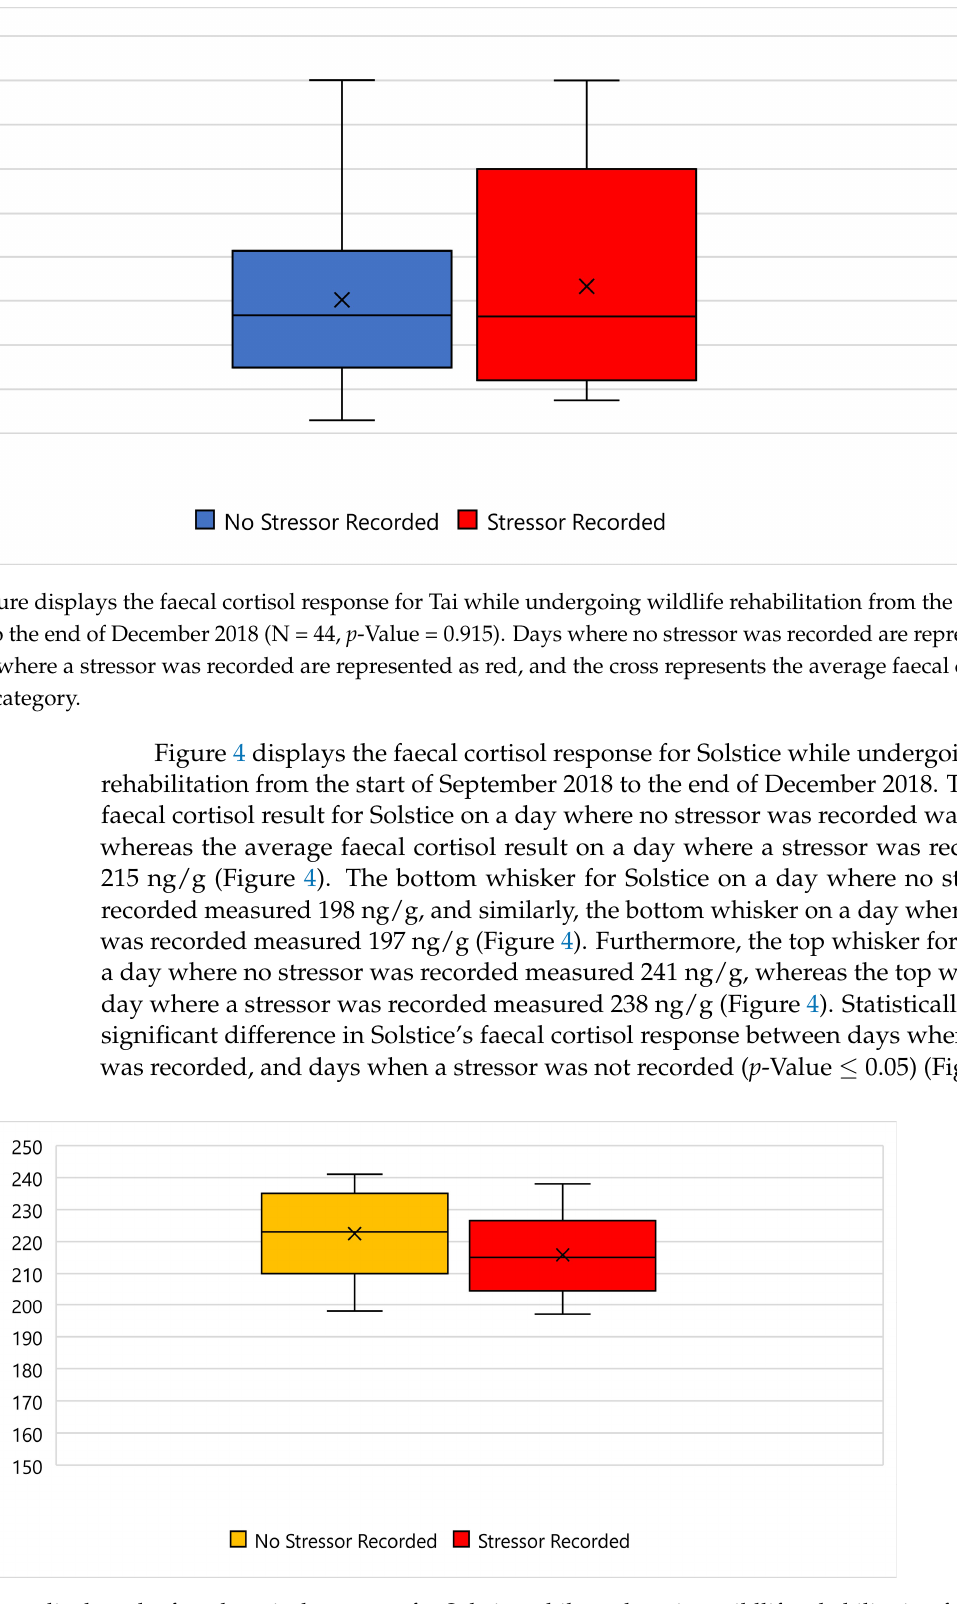
Figure 4. This figure displays the faecal cortisol response for Solstice while undergoing wildlife rehabilitation from the start of September 2018 to the end of December 2018 (N = 44, p -Value = 0.000). Days where no stressor was recorded are represented as yellow, the days where a stressor was recorded are represented as red, and the cross represents the average faecal cortisol reading for each